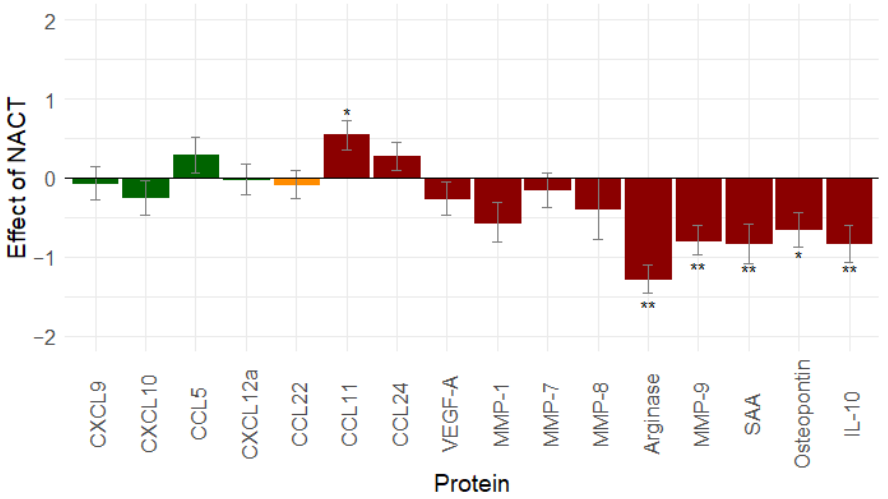
Figure 1. Effect of neo-adjuvant chemotherapy ( n = 55) on immune-related proteins: platin-based neo-adjuvant chemotherapy mainly decreases immunosuppression. Proteins in green are immune stimulatory factors, proteins in red are immune inhibitory factors, proteins in orange have a dual function. *: 0.01 ≤ p -value < 0.05; **: p -value < 0.01. Abbreviations: CCL, C-C motif chemokine ligand; CXCL, C-X-C motif chemokine ligand; IL-10, interleukin-10; MMP, matrix metallopeptidase; NACT, neo-adjuvant chemotherapy; SAA, serum amyloid A; vascular endothelial growth factor (VEGF).